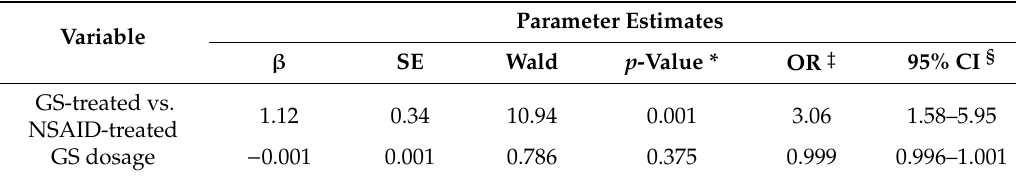
Table 4. Glucosamine sulfate treatment associated with the risk of receiving total joint arthroplasty by logistic regression analysis.